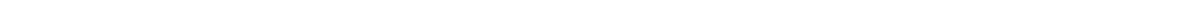
Fig. 1 Interferon-induced MxB inhibits HSV-1 replication. a T98G human glioblastoma cells were transfected with non-targeting siRNA (siNT) or siRNA targeting endogenous MX2 (siMxB UTR). At 30 h post transfection, cells were mock-stimulated or stimulated with human IFN- α 2 (1000 IU/ml) for 18 h. MxB protein expression and intracellular localisation was assessed by immunostaining. Nuclei were stained with Hoechst 33342. Scale bar, 20 µ m. b , c T98G cells were transfected with non-targeting siRNA (siNT) or two different siRNAs targeting endogenous MX2 (siMxB UTR, siMxB #1). At 30 h post transfection, cells were mock-stimulated or stimulated with human IFN- α 2 (500 IU/ml). At 48 h post transfection, cells were infected with HSV-1 strain MacIntyre ( b ) or F ( c ) at a multiplicity of infection (MOI) of 0.1 for 32 h. Cell culture supernatants were subjected to TCID 50 assay and cells were lysed and pooled for immunoblot analysis of MxB protein expression, MX2 silencing ef fi ciency and HSV-1 late protein VP16 expression. MxA served as a control for siRNA speci fi city and GAPDH served as a loading control. Titres of mock-stimulated samples are each set to 100%. Bars indicate relative mean ± s.d., n = 6 biological replicates. ANOVAs modelling log-transformed relative titre with IFN and siRNA as explanatory variables: HSV-1 MacIntyre: IFN, F (1,30) = 1215.74, p < 0.0001; siRNA, F (2,30) = 13.67, p < 0.0001; antagonising interaction, F (2,30) = 14.81, p < 0.0001. HSV-1 F: IFN, F (1,30) = 587.29, p < 0.0001; siRNA, F (2,30) = 39.55, p < 0.0001; antagonising interaction, F (2,30) = 33.63, p < 0.0001. d T98G cells were siRNA-transfected and stimulated with human IFN- α 2 as in b , but then mock-infected or infected with HSV-1 recombinant strain C12 expressing GFP (MOI = 0.1). Virus growth was determined by real-time quanti fi cation of GFP fl uorescence. Upper panel: Data points indicate the integrated green object intensity normalised to cell con fl uence (mean ± s.d., n = 3 biological replicates). Lower panel: Relative area under the curve from 0 to 72 h post infection. GFP signals of mock-stimulated samples are each set to 1. Bars indicate relative mean ± s.d., n = 3 biological replicates. ANOVA modelling relative area under the curve with IFN and siRNA as explanatory variables: IFN, F (1,12) = 23,829.4, p < 0.0001; siRNA, F (2,12) = 211.3, p < 0.0001; antagonising interaction, F (2,12) = 211.3, p < 0.0001. All data are representative of two independent experiments. a.u., arbitrary units. Multiple comparisons: **** p <